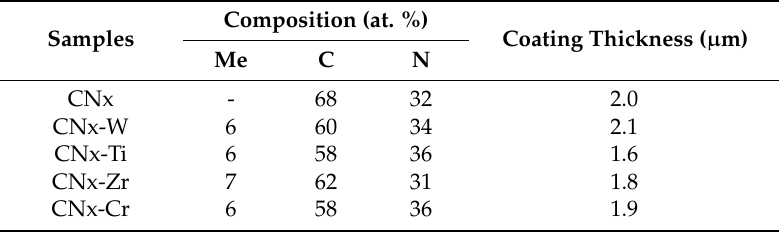
Table 1. Composition and thickness of CNx and 6 at. % metal-doped CNx coatings.